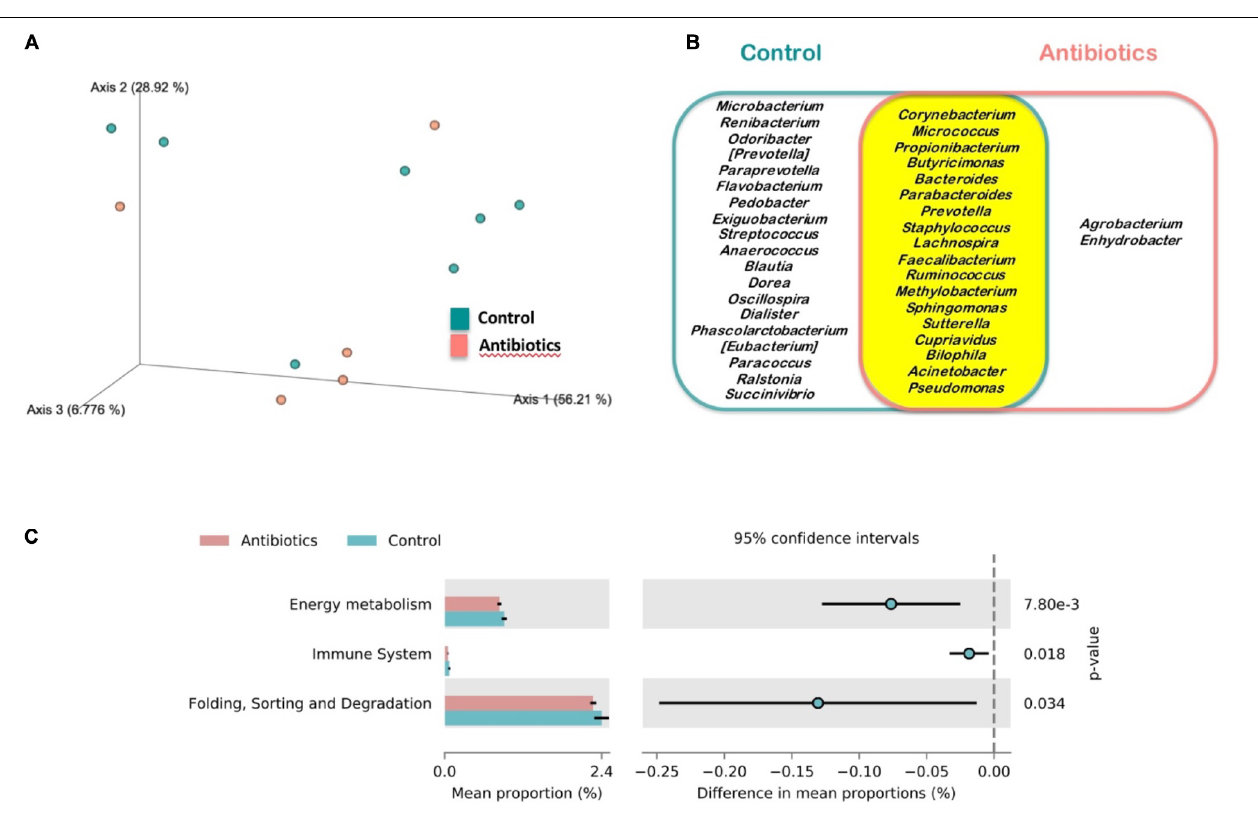
FIGURE 3 | Microbiota analysis of mosquitoes treated with antibiotics (red) and control mosquitoes (blue). (A) Principal Coordinates Analysis (PCoA) of bacterial communities. (B) Venn diagram of the core microbiomes at genus level of the analyzed mosquitoes for the case of bacteria identified in control mosquitoes (blue), mosquitoes treated with antibiotics (red) and those shared by mosquitoes of both experimental groups (yellow). (C) Differentially abundant KEGG pathways identified at level 2 in both sampled